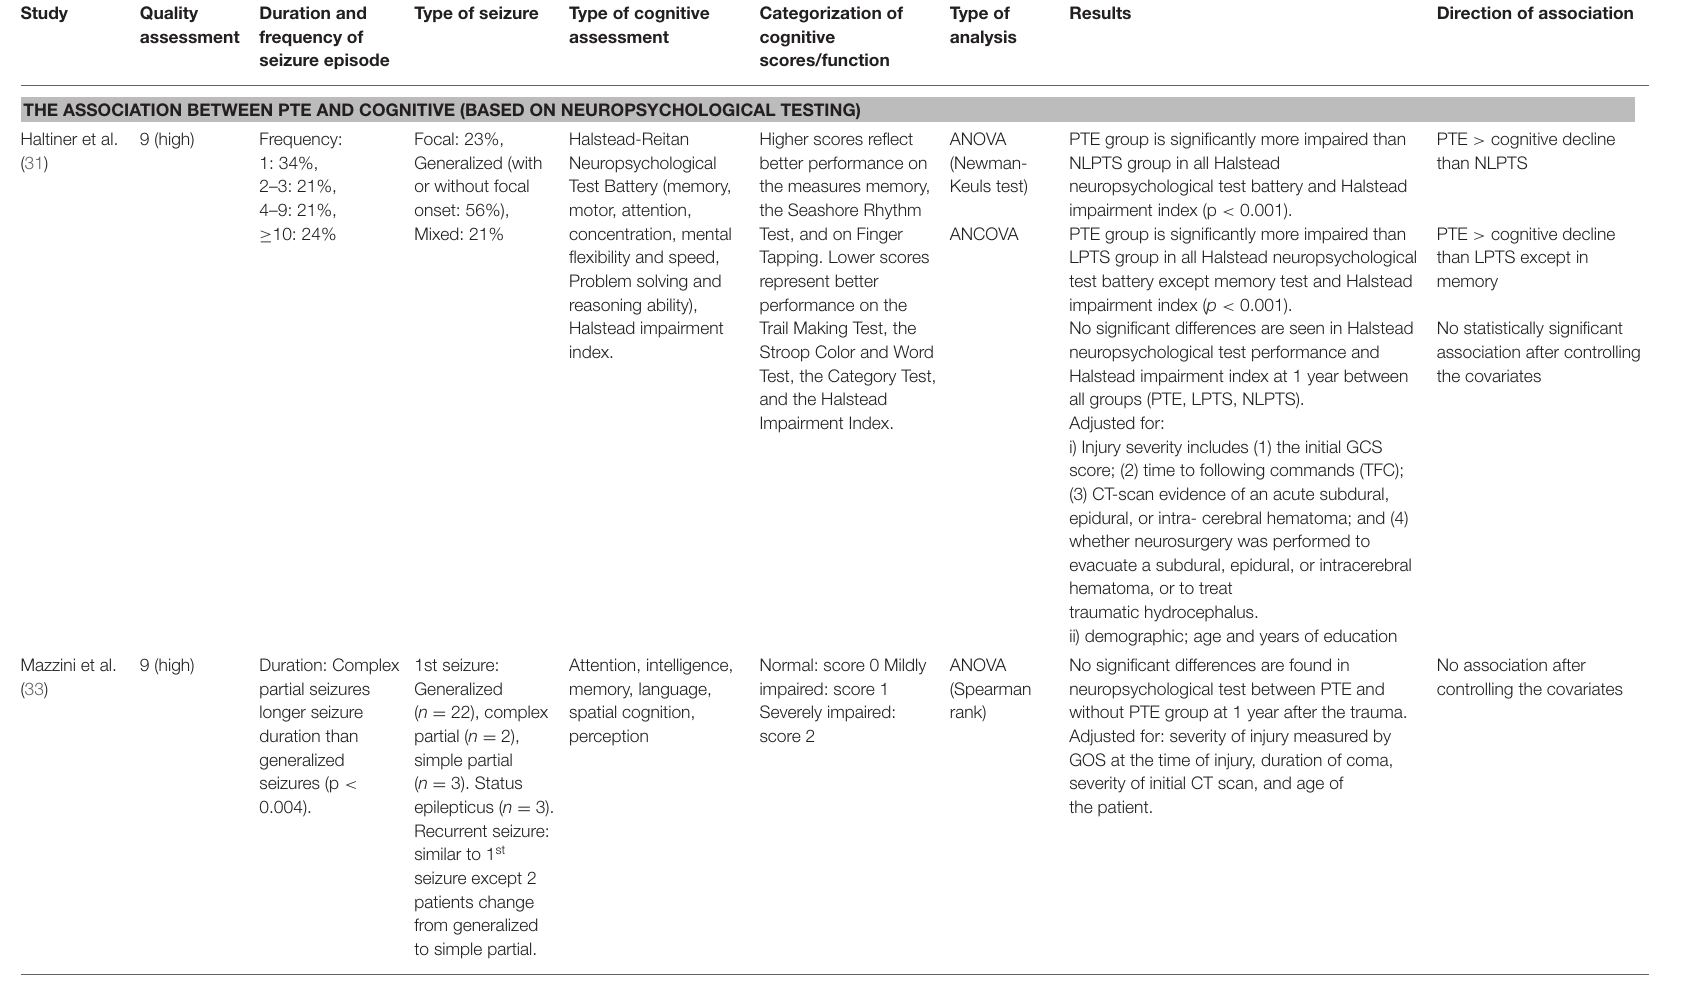
TABLE 2 | The association between post-traumatic epilepsy (PTE) and cognitive performance. Type of Results Type of seizure Type of cognitive Categorization of Study Quality Duration and analysis assessment cognitive assessment frequency of scores/function seizure episode THE ASSOCIATION BETWEEN PTE AND COGNITIVE (BASED ON NEUROPSYCHOLOGICAL TESTING) Haltiner et al.